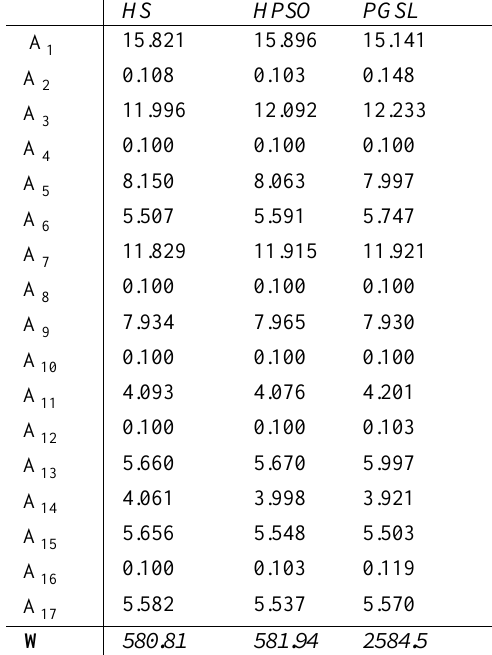
Table 4 . Table 4. 17-bar truss: optimal design comparison HS HPSO